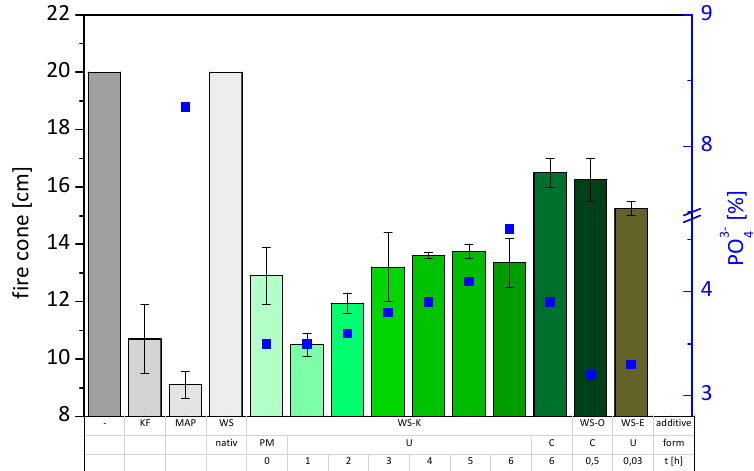
Figure 3. Results of fire test according to ISO 11925, fire cone height of the specimens with various additives, left to right: without additive, commercial flame retardant KF , pure MAP , native wheat starch ( WS ), several variations of WS-K , as physical mixture ( PM ), in uncleaned form ( U ), after different times of reaction, and in cleaned form ( C ) after 6 h reaction; phosphate content of the specimens ■.